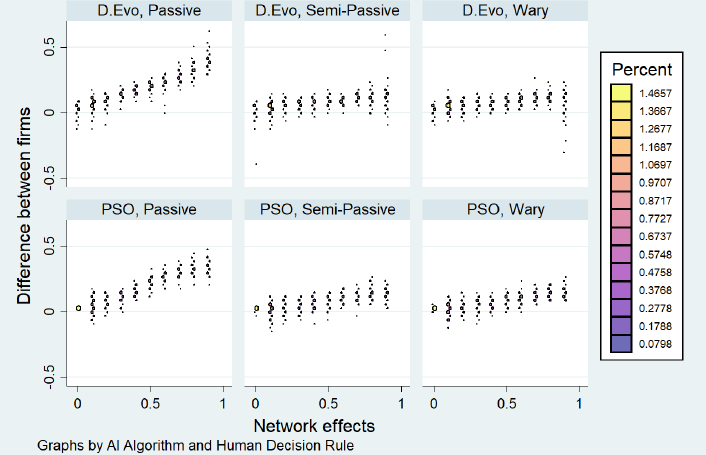
Figure 7. Difference in profits between the best-response agent and algorithms. Source: